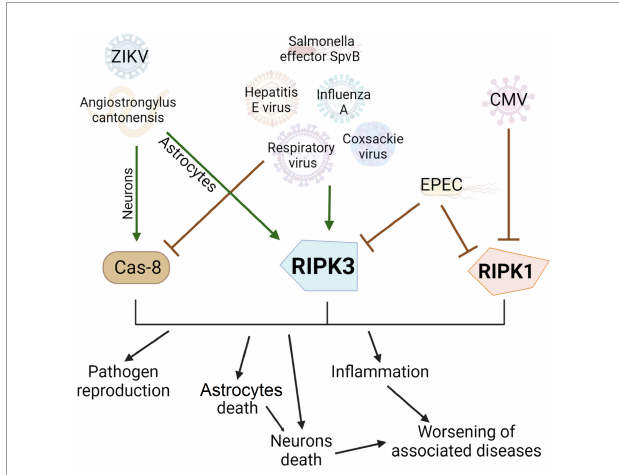
FIGURE3 Effect of viruses, bacterial and other pathogens on the development of necroptosis and apoptosis. Pathogens can be conventionally divided into three groups: activating apoptosis, activating necroptosis, or blocking cell death. Many pathogens, such as the hepatitis E virus, have developed evolutionary adaptations to prevent apoptosis by blocking Caspase 8. In this case, the infected cell will live longer and more copies of the virus will be produced. However, this contributes to the activation of another type of cell death, necroptosis, via RIPK3 activation. Enteropathogenic E. coli can inhibit the main proteins of necroptosis and prevent this type of cell death. Interestingly, the Zika virus causes necroptosis in the cell, which limits the replication of the virus and has no apparent evolutionary advantage but causes extensive inflammation in the